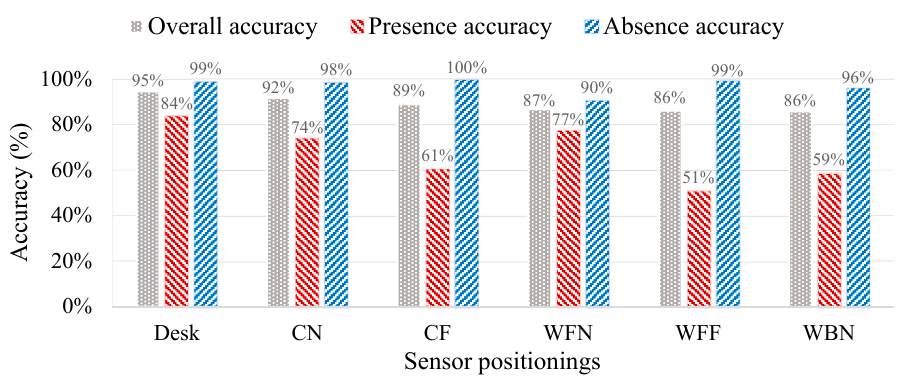
Figure 3. Accuracy of occupancy detection by different PIR sensors in different positions.